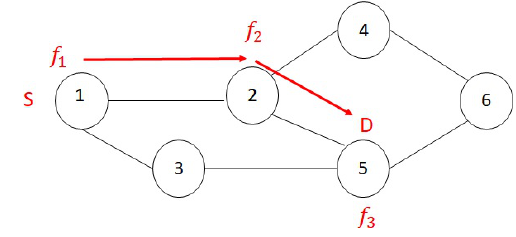
Figure 5. FACE heuristic